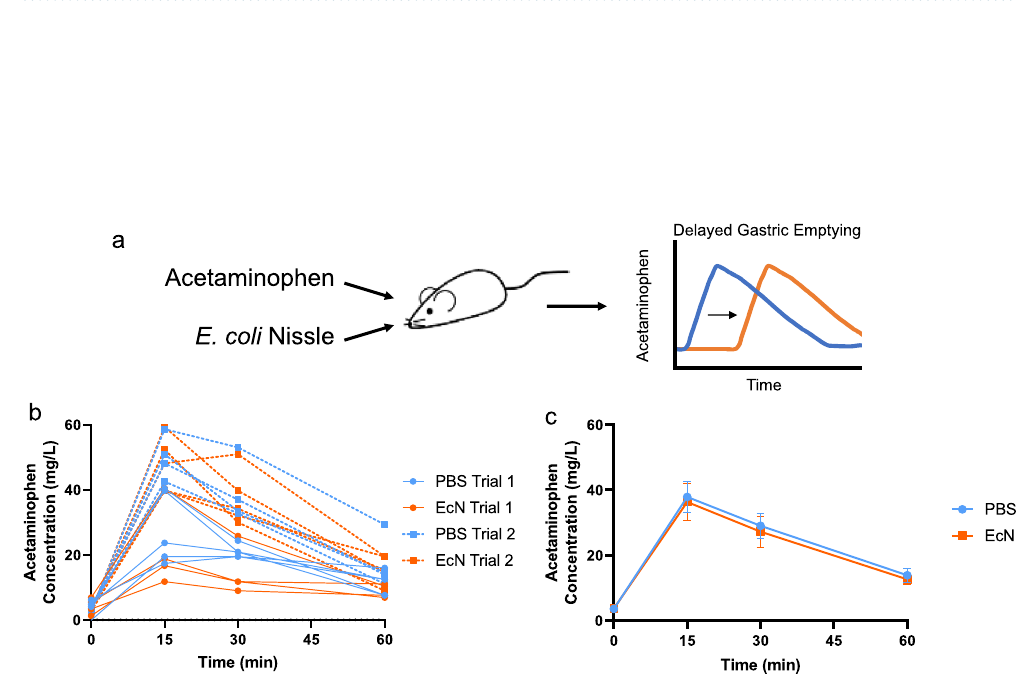
Figure 3. Impact of E. coli Nissle on gastric emptying rate. ( a ) Experimental design. Acetaminophen is co-administered with bacteria or PBS as an oral gavage. Acetaminophen acts as a tracer to monitor rate of gastric emptying and further clearance from the blood. ( b,c ) Concentration of acetaminophen in the blood over time following oral gavage (n = 9). In ( b ), points represent individual mice, while in c points represent mean and bars represent SEM. p values calculated in b and c using repeated measures ANOVA with Tukey’s post-hoc